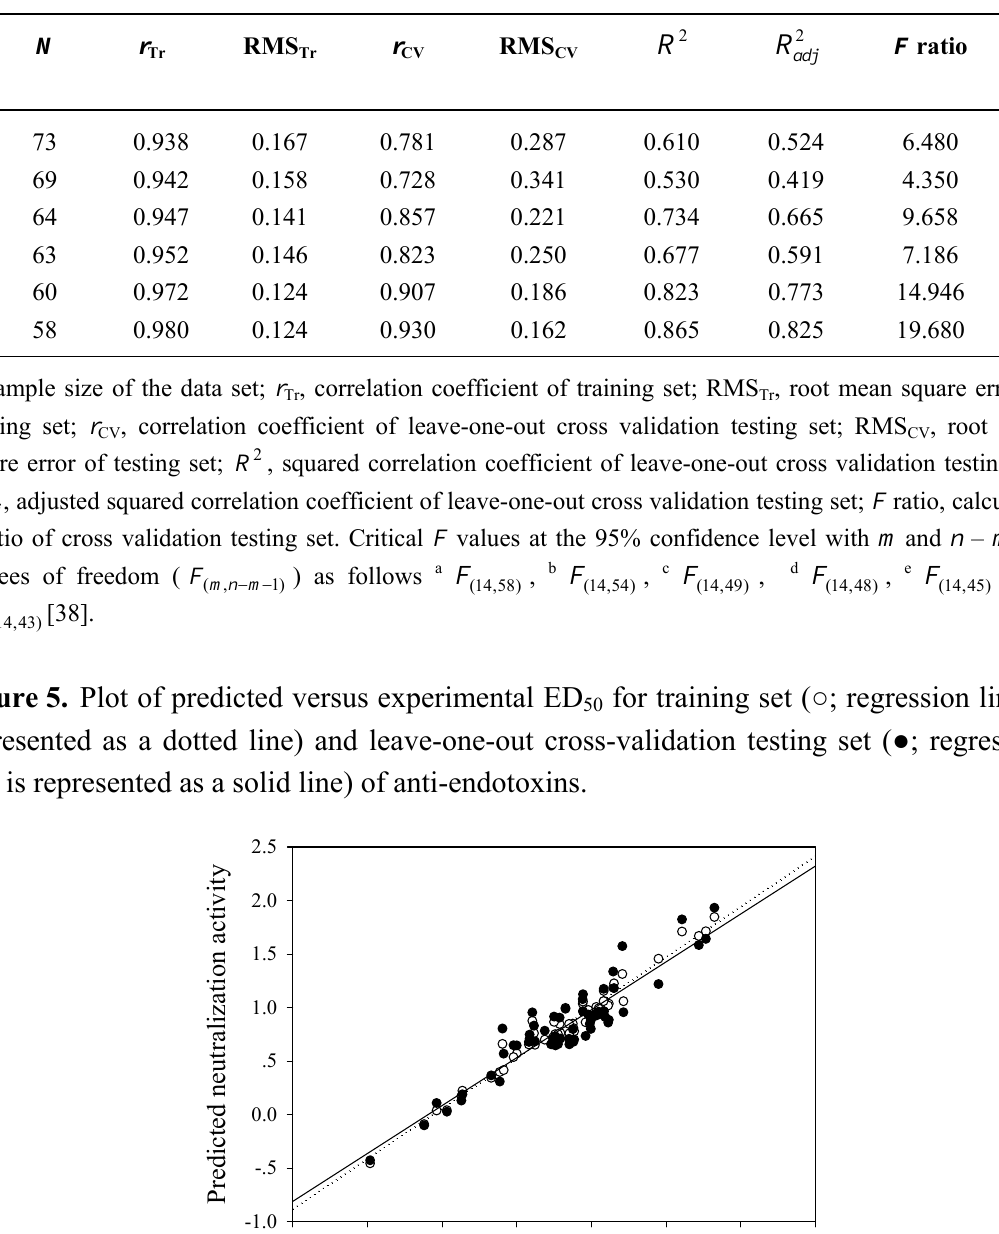
Table 1. Summary of the predictive performance.